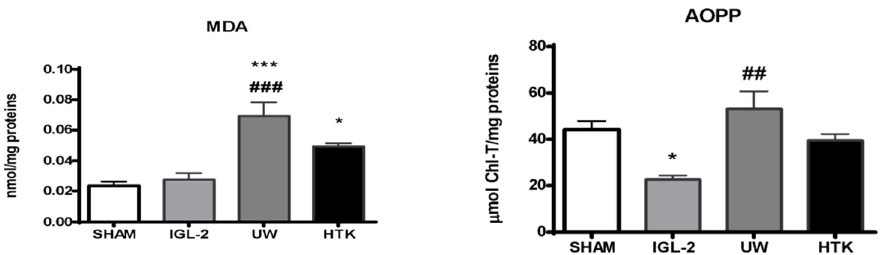
Figure 4. Lipid peroxidation (measured as MDA levels) and oxidized proteins (AOPP) in liver grafts in IGL-2, UW, and HTK solutions (24 h; 4 °C). The bars represent the mean values ± SEM of each group (n = 4–6). Differences are shown comparing groups (* vs. Sham, # vs. IGL-2) according to the one-way ANOVA test and the Tukey post-hoc test (one symbol indicates p < 0.05; two symbols indicate p < 0.01; three symbols indicate p < 0.001).